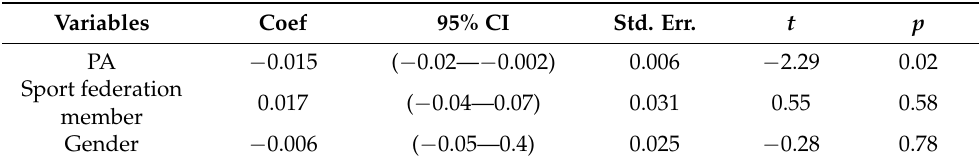
Table 2. Linear regression between the number of cigarettes consumed and its associated variables. Adjusted by age.